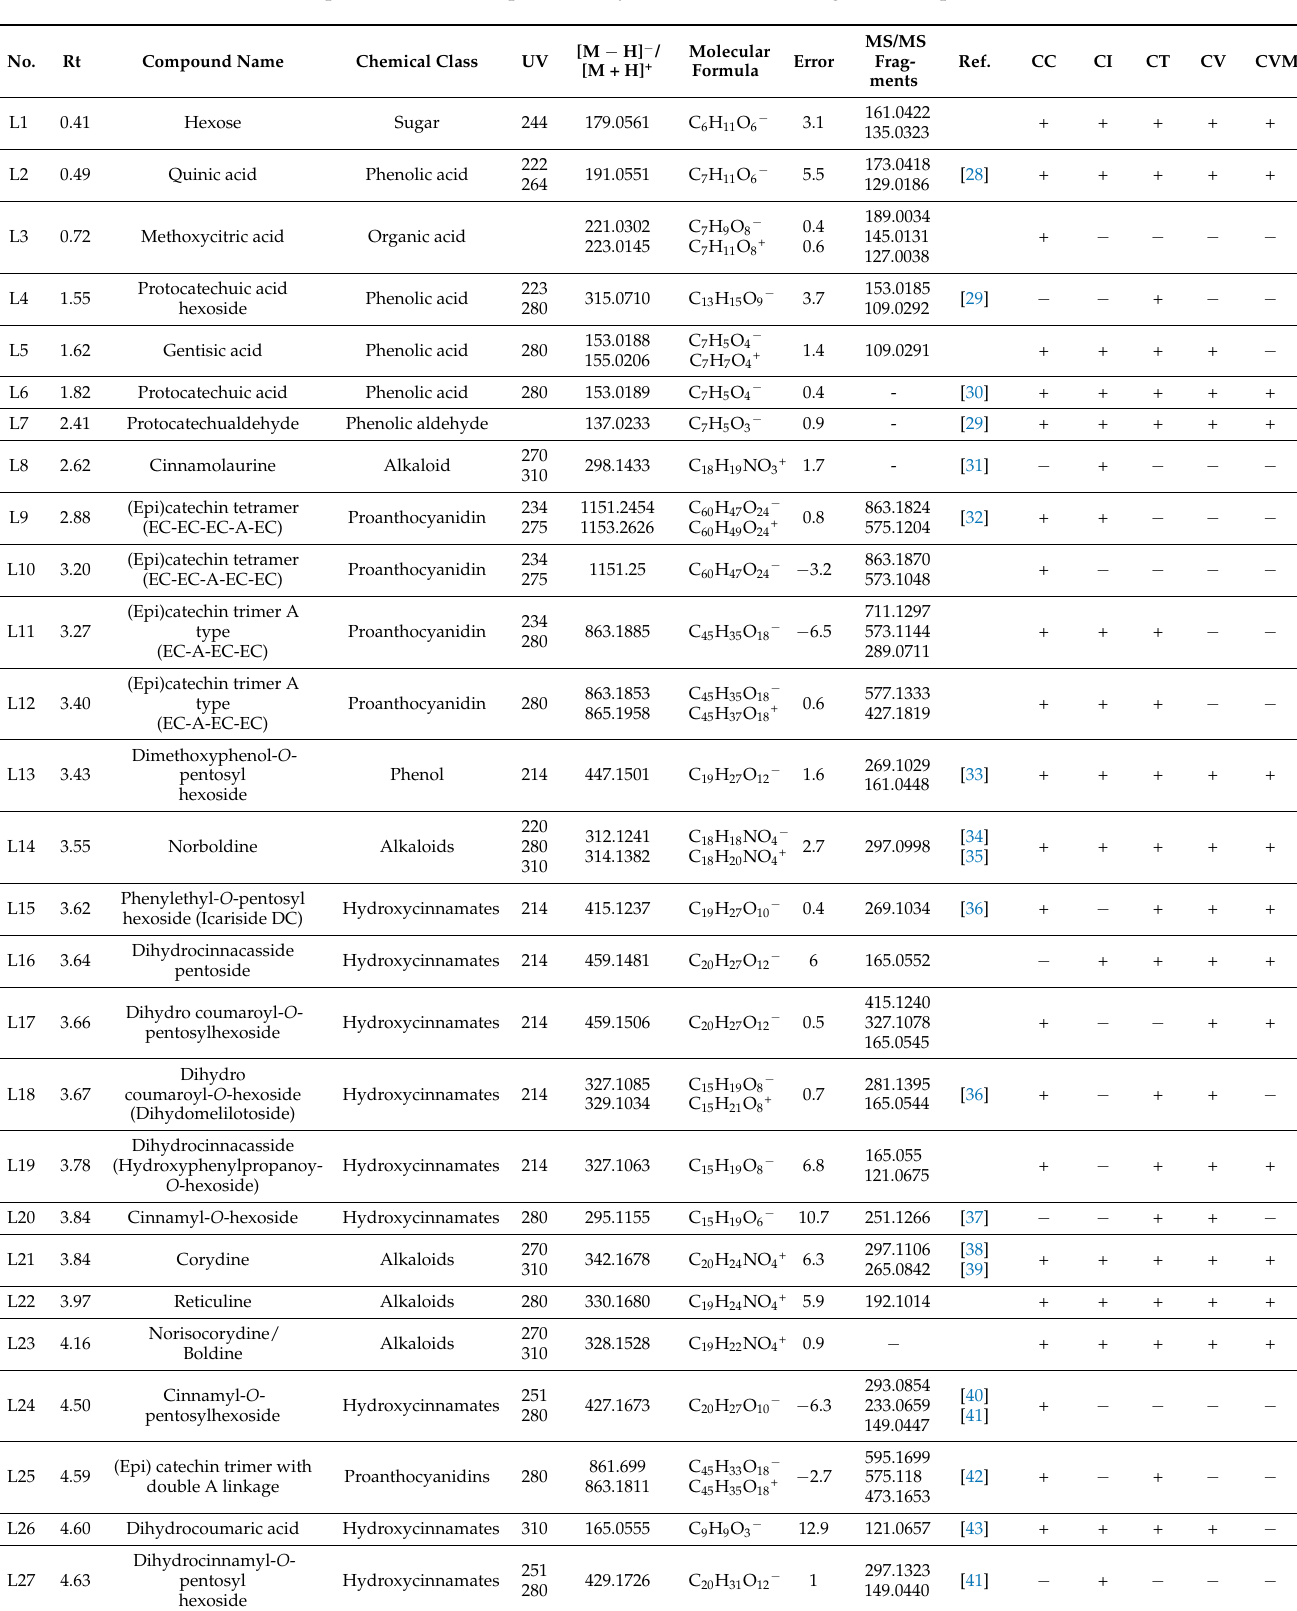
Table 1. Metabolites identified in 70% methanol extract of Cinnamomum species by UPLC-ESI-MS (peak numbers are preceded by L in text) in both negative and positive ionization